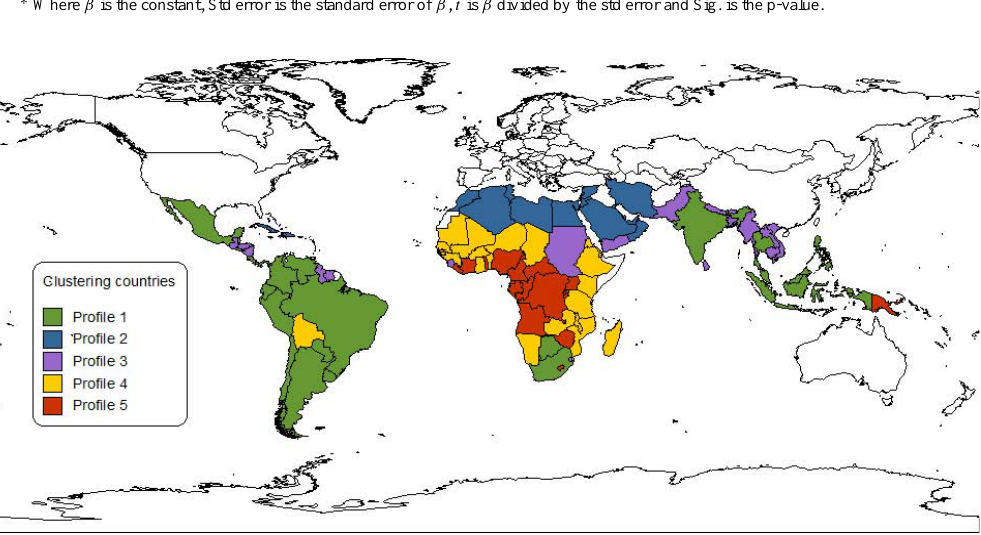
Fig. 4. Geographical distribution of the five country